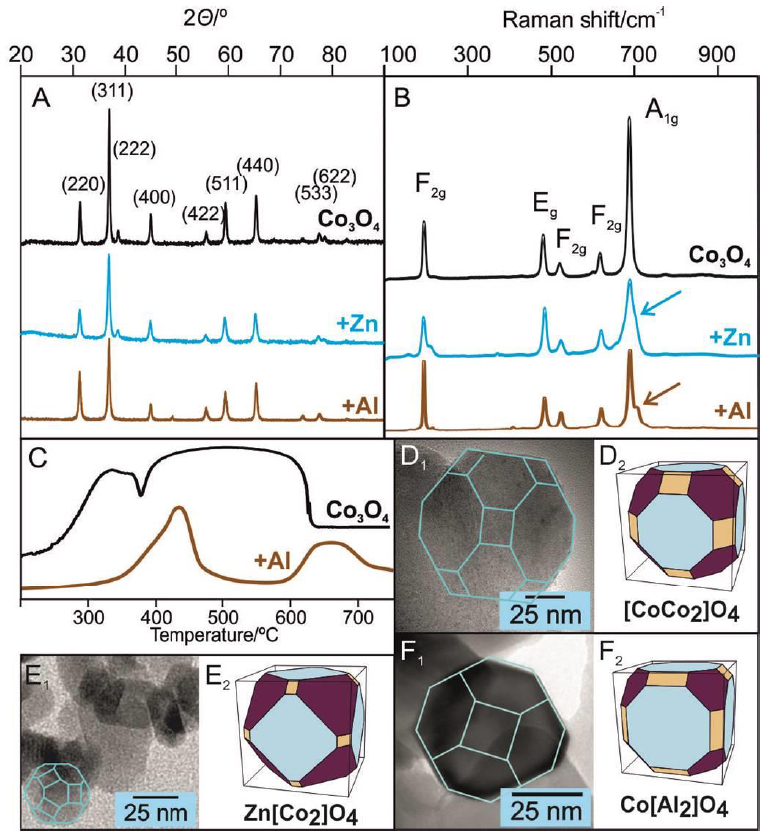
Figure 2. Physicochemical characterization of bulk-promoted cobalt spinel catalysts ( A – C ); transmission electron microscopy (TEM) image of Co 3 O 4 nanocrystals ( D 1 , E 1 , F 1 ) and models of exposed facets ( D 2 , E 2 , F 2 ): (111), (110), (100) marked by blueberry, peach, and pale cyan colors, respectively ( F ) [33].